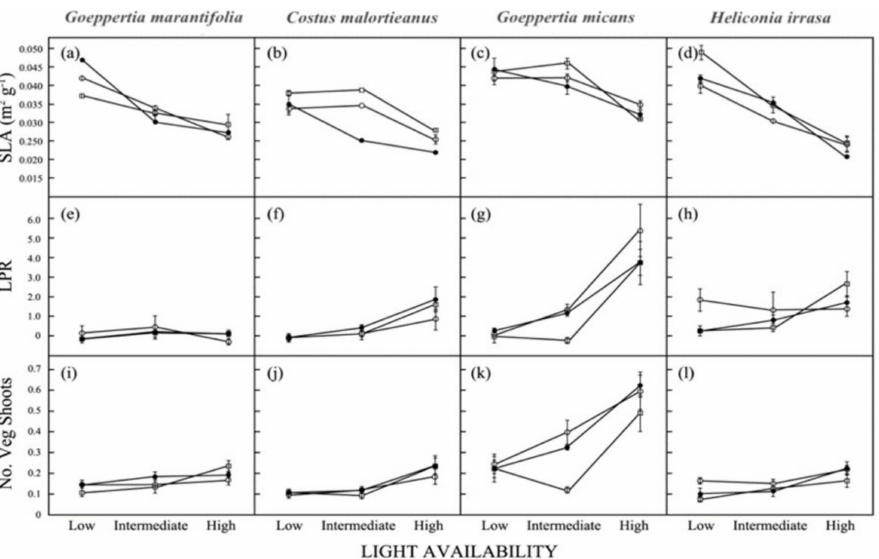
Figure 5. SLA, ( a – d ), leaf production rate (LPR, ( e – h )), and number of vegetative shoots ( i – l ) for four understory herb species. Values shown are mean ± 1